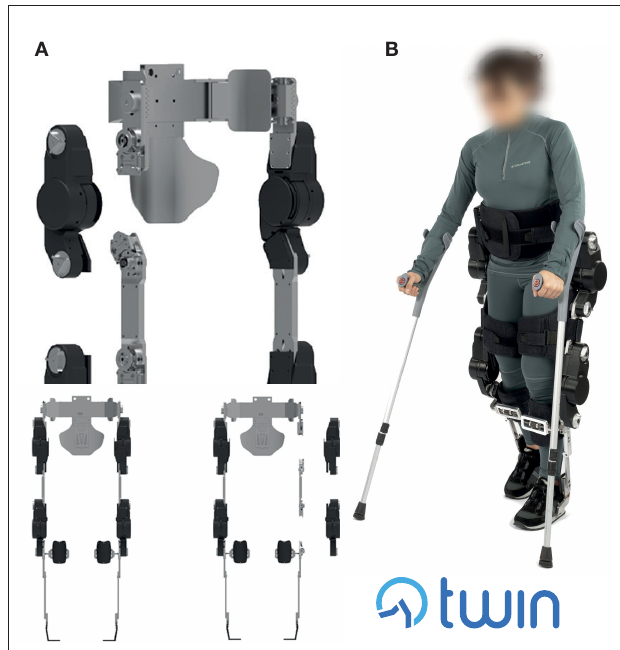
FIGURE 4 | (A) TWIN’s modular structure and lateral mounting of the modules, (B) The TWIN lower limb exoskeleton in walking mode worn by a subject. The person wearing the exoskeleton gave permission for the use of her